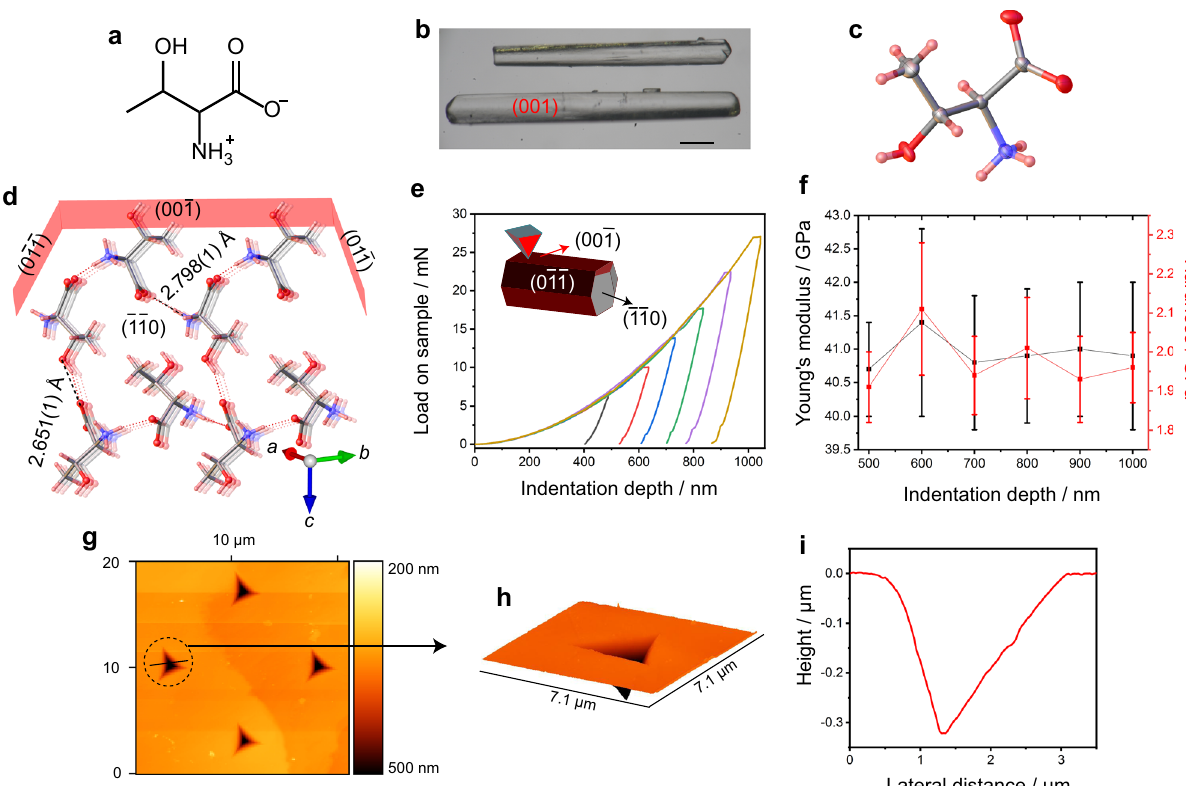
Fig. 1 Structure and mechanical properties of L-threonine crystals. a Chemical structure showing the zwitterionic form of threonine (the stereochemistry is not shown). b Optical microscopic image of typical crystals under study. The length of the scale bar is 500 μ m. c ORTEP diagram of L-threonine shown at 50% ellipsoid probability level. d Molecular packing diagram showing head ‐ to ‐ tail packing in the structure of L-threonine and hydrogen bonds as broken lines. e Load – depth curves recorded from an L-threonine crystal on its (00 (cid:1) 1) face at different penetration depths. f Young ’ s modulus ( E ) and hardness ( H ) based on the curves similar to those shown in ( e ). The error bars show the standard deviations that were calculated from 25 indents at each indentation depth. g An example of AFM topography images of the indent impressions. h Topography of a typical indent showing absence of material pileup. i Height pro fi le of the indent shown in ( h